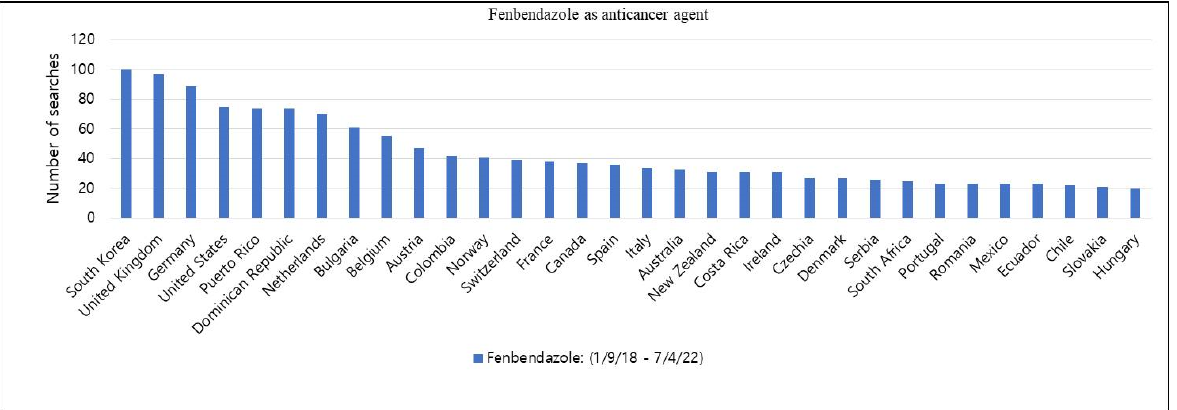
Figure 3. Dissemination of Joe Tippens’ cure story. Thousands of people globally read, listened to, and followed his protocol after his success. The data represent the number of searches conducted by different countries. A value of 100 indicates the highest popularity with the highest number of searches, while 0 indicates the lowest popularity with the lowest number of searches. The data were collected using Google Trends and Naver Data Lab (South Korea search engine).